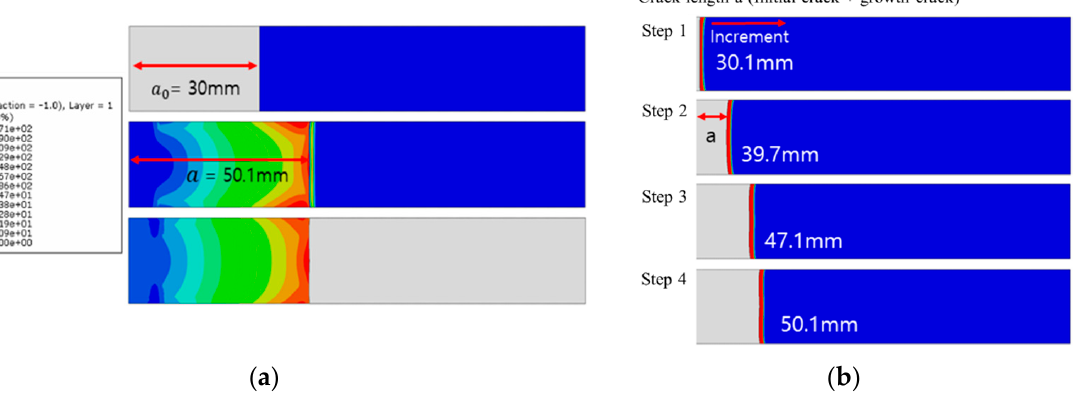
( b ) Figure 16. Comparative analysis of specimen-level FE analysis results and Mixed-mode test results: ( a ) P −𝛿 curve and ( b ) G (I+II) − a curve. On the other hand, in Figure 17, crack growth was observed as the stress propagated from the center of the specimen to the edge. Figure 17a shows the initial crack selection,